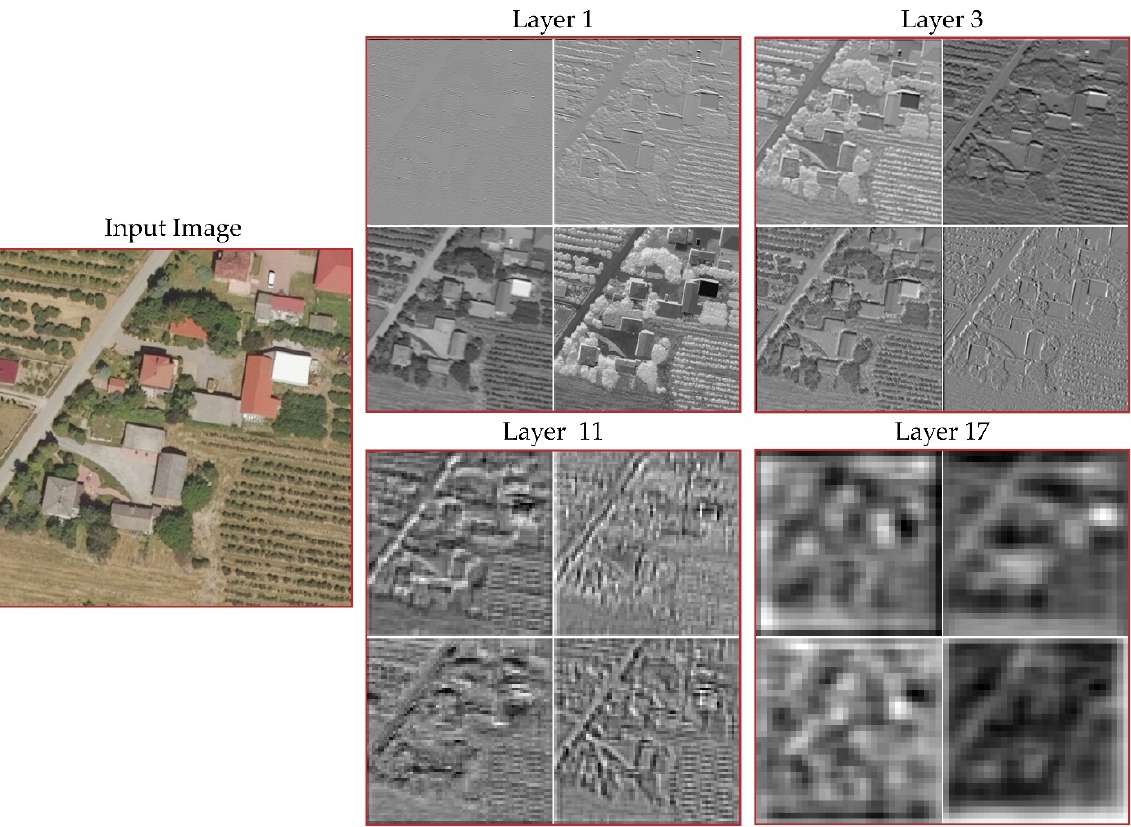
Figure 1. Example feature maps generated by convolutional operations. Example data are from the LandCover.ai dataset [28]. The subset of feature maps shown for each convolutional layer are from a ResNet-18 backbone [31] with ImageNet [32] pre-trained weights. Many feature maps are generated by each convolutional layer, so only a subset of four feature maps from four layers are shown here.